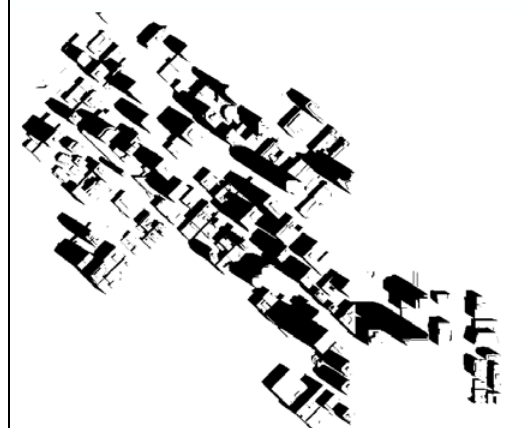
Figure 3. Artificial shadow image of